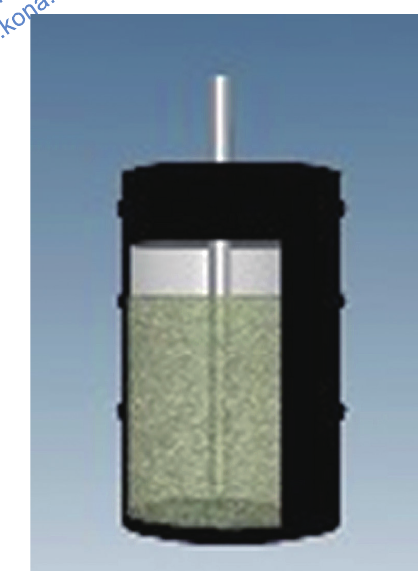
Fig. 1 Thief or spear sampling. (Courtesy of EET Corporate, www.eetcorp.com)